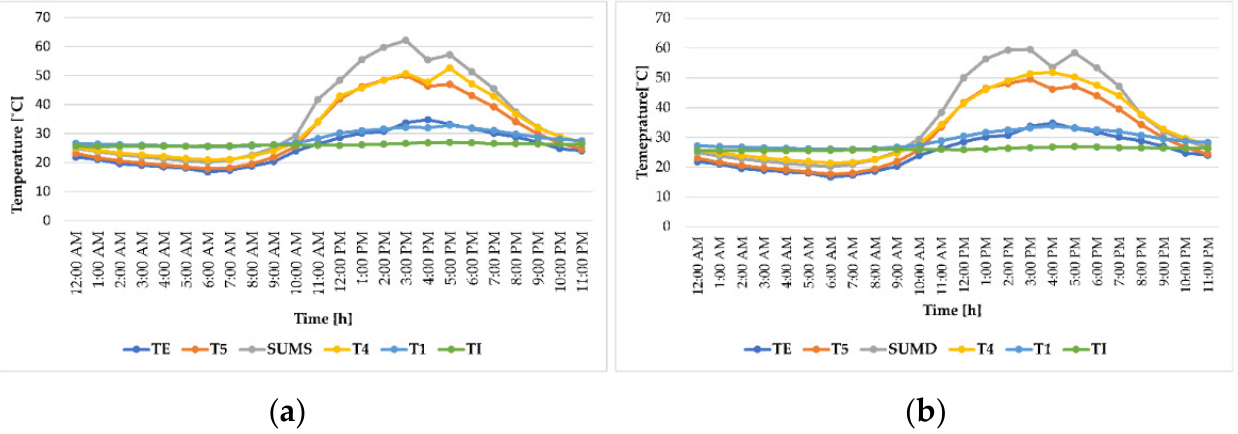
Figure 7. Horizontal hourly temperature variation for two lines of translators, 29 July 2013. Position in the middle-left ( a ) and in the middle-right ( b ).